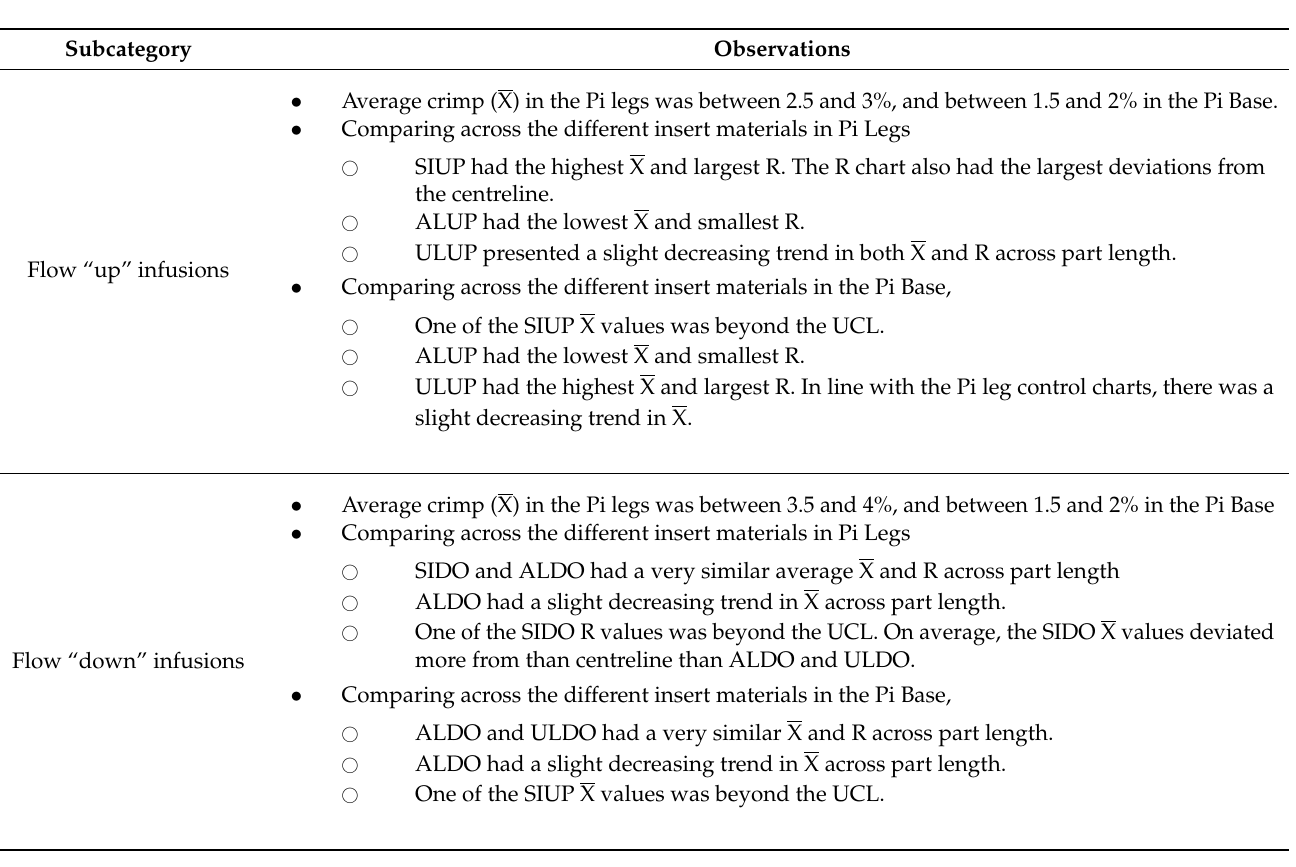
Table 5. Control chart